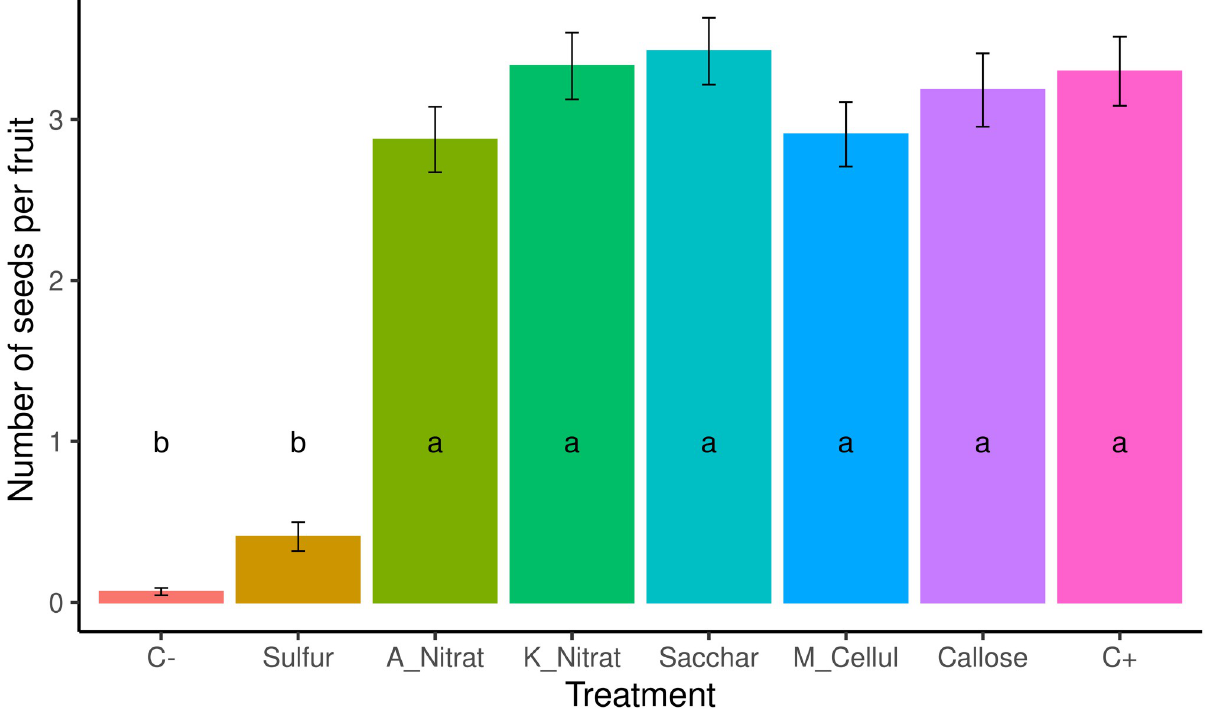
Fig 1. Bar plot for the effect of treatment on the average seed number per fruit. Different letters denote the statistically significant differences in the Kruskal-Wallis test ( post hoc Nemenyi (Tukey) test), for alpha � 0.05 (KW value = 56.133; p-value = 3.87e-67). Error lines correspond to the standard error. Treatments are noted as: C-, negative control; Sulfur; A_Nitrat, ammonium nitrate; K_Nitrat, potassium nitrate; Sacchar, saccharose; M_Cellul, methyl cellulose; Callose; C+, positive control.